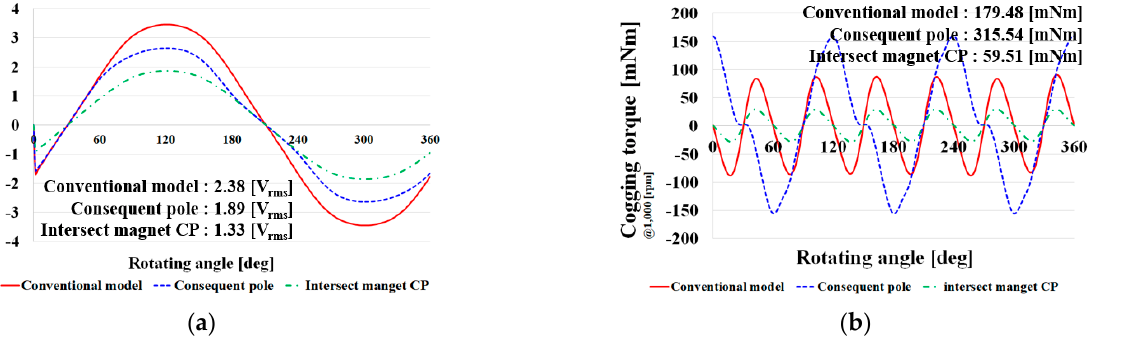
Figure 6. Noload back emf and cogging torque waveform of conventional model, consequent pole model and intersect magnet CP (3D simulation result): ( a ) noload back emf, ( b ) cogging torque.